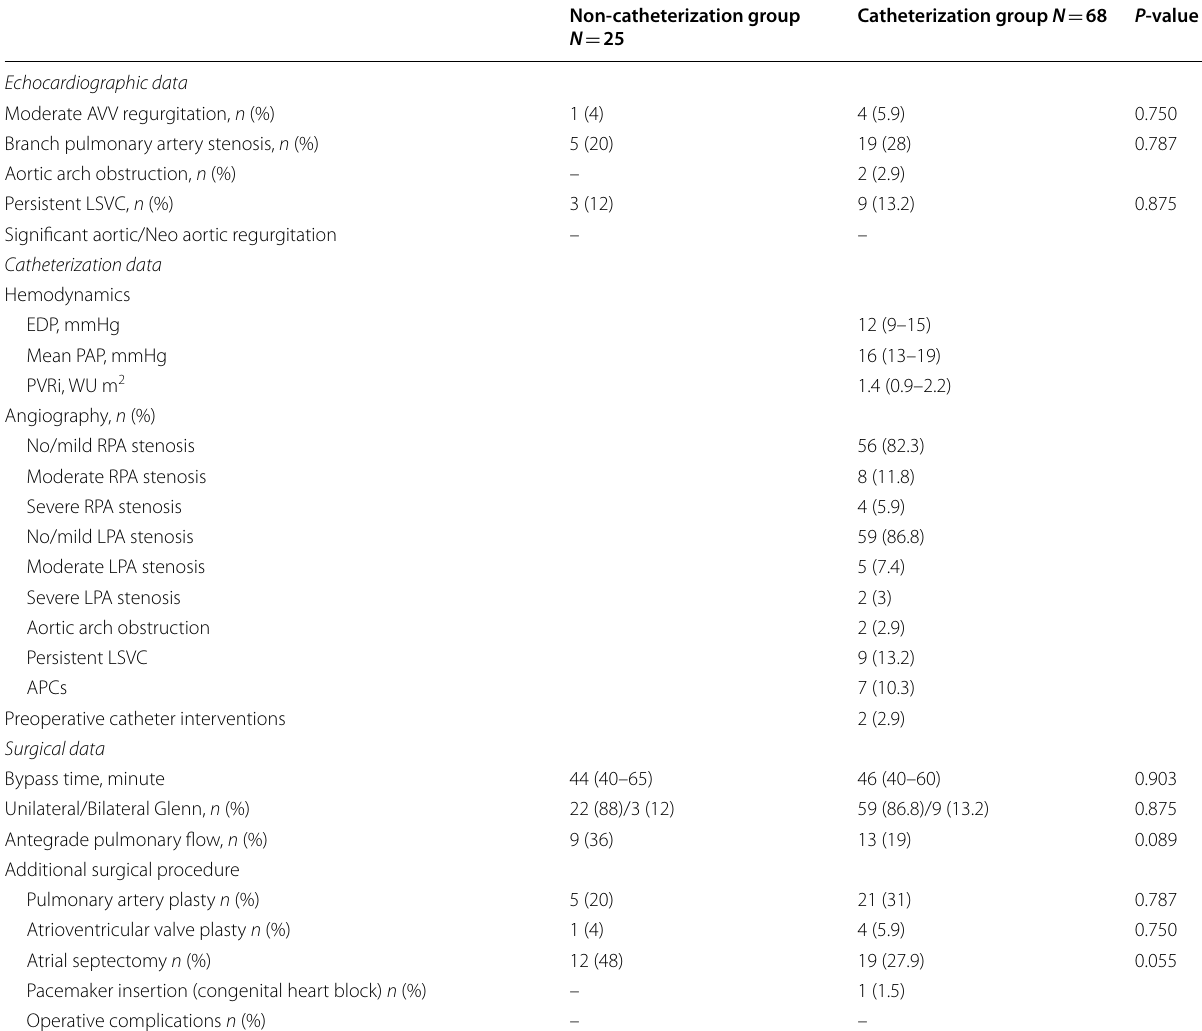
Table 2 Echocardiographic, catheterization and surgical data of patients’ groups